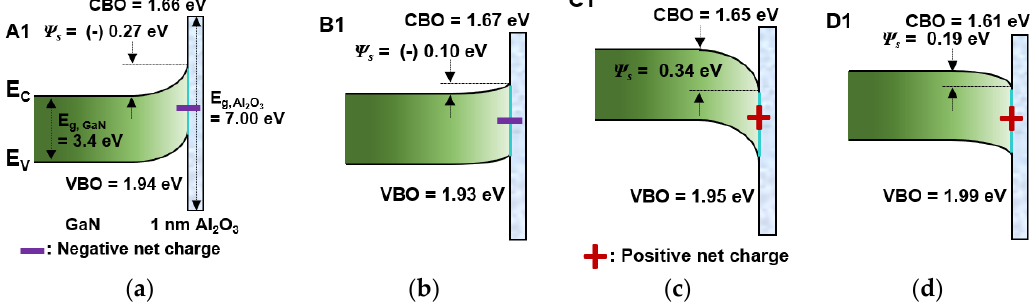
Figure 4. Energy band bending at 1 nm Al 2 O 3 /GaN interfaces with estimated surface potential ( Ψ s), valence band offset (VBO), and conduction band offset (CBO) of samples ( a ) A1, ( b ) B1, ( c ) C1, and ( d ) D1.